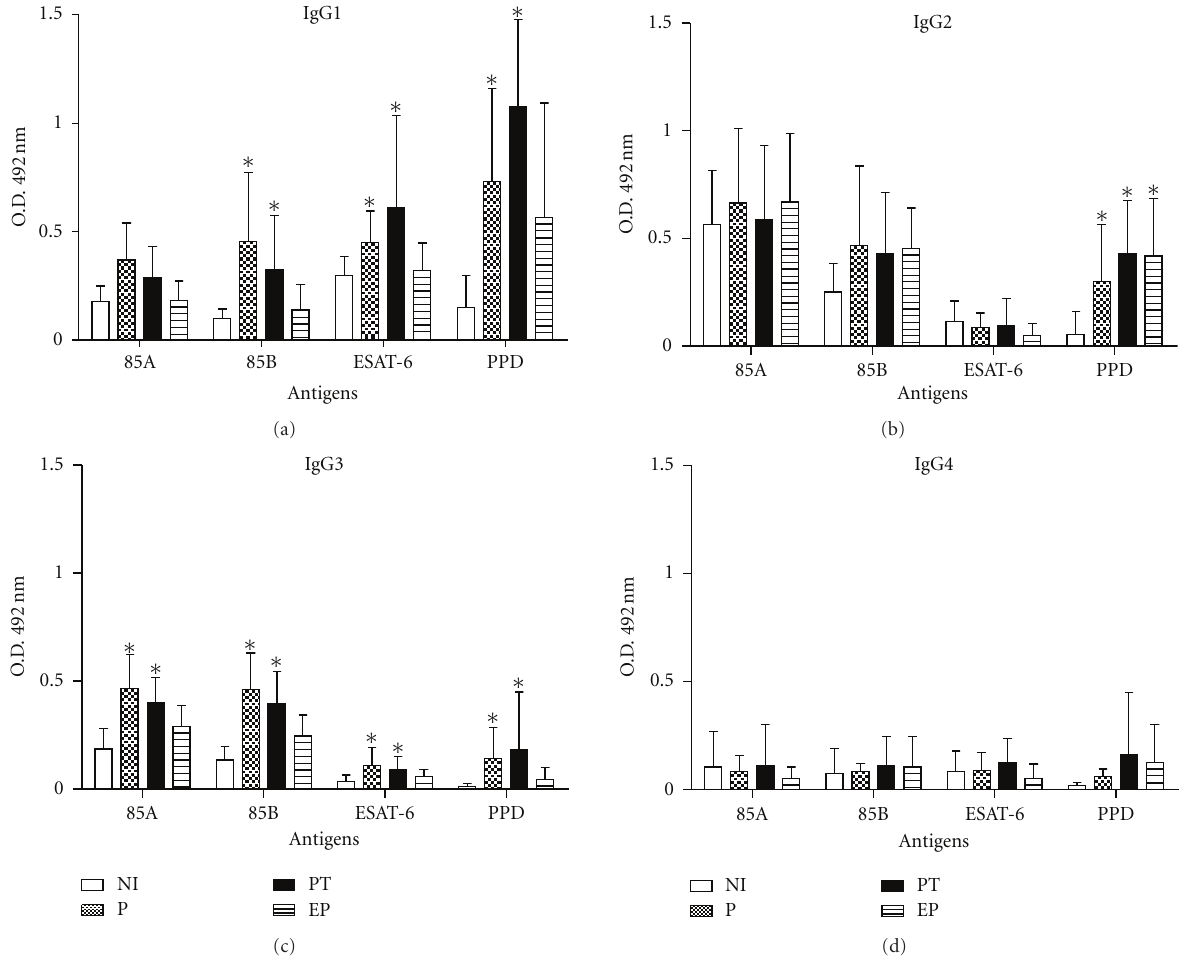
Figure 2: Levels of serum IgG1 (a), IgG2 (b), IgG3 (c) and IgG4 (d) to Ag85A, Ag85B, ESAT-6, and PPD were determined in serum of non-infected individuals (NI), pulmonary tuberculosis patients (P), pulmonary tuberculosis patients undergoing treatment (PT) and extra- pulmonary tuberculosis (EP). Results are presented as mean ± standard deviation. Di ff erences between responses from TB patient groups and control groups were analyzed with nonparametric Kruskall-Wallis test. ∗ Statistically significant di ff erences in relation to NI group ( P < .